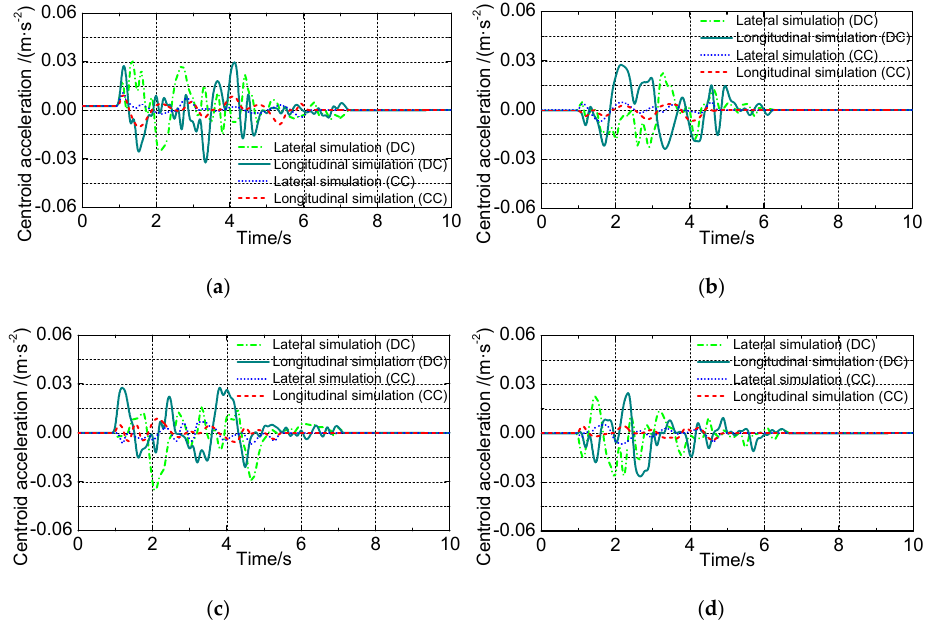
Figure 12. Longitudinal and lateral acceleration of four off-center arms during motion mode switching: ( a ) cross motion; ( b ) in-place rotation; ( c ) diagonal motion; ( d ) steering motion.